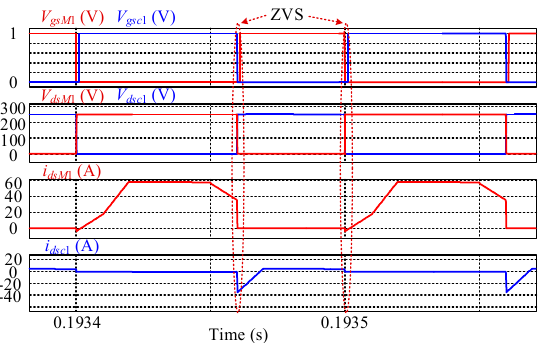
Figure 15. Zero voltage switching (ZVS) of switches in the primary circuit.